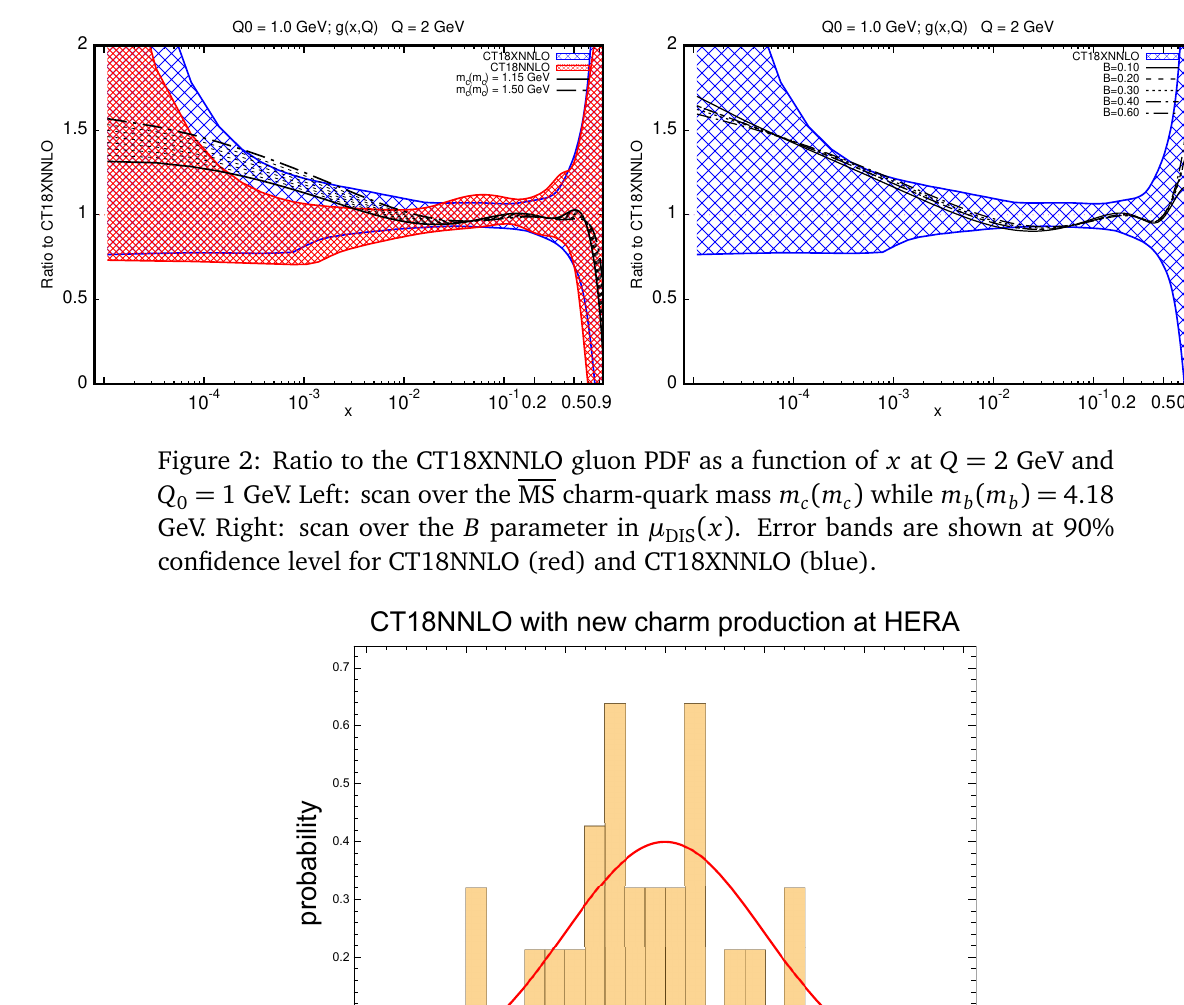
Figure 3: Distribution of the residuals for the new charm production at HERA in the CT18NNLO global